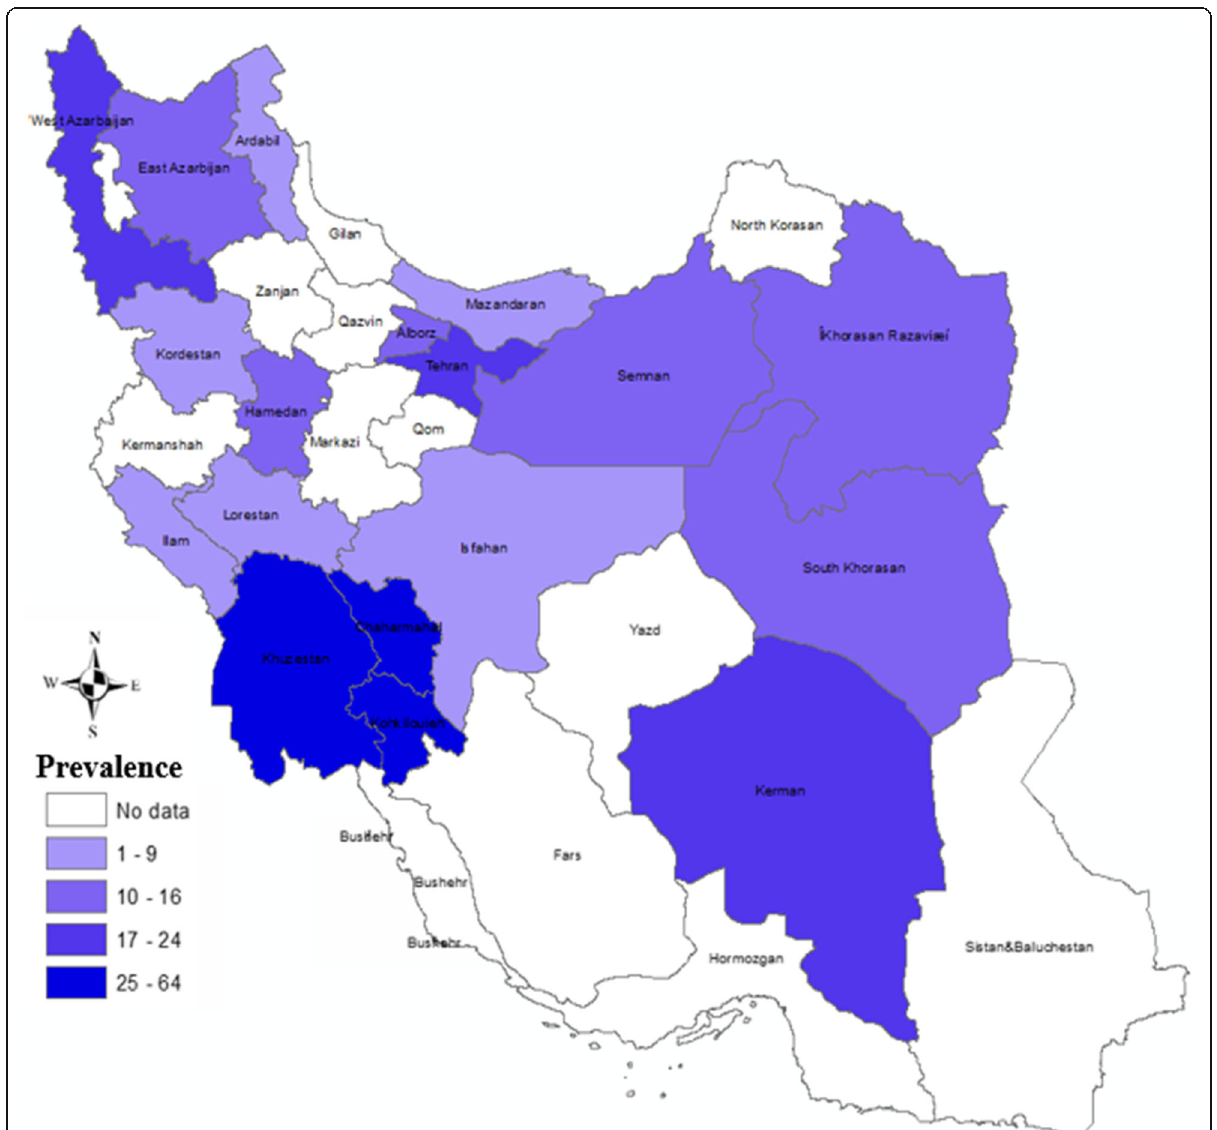
Fig. 9 Incidence of Cryptosporidium infection in the Iranian cattle in different provinces